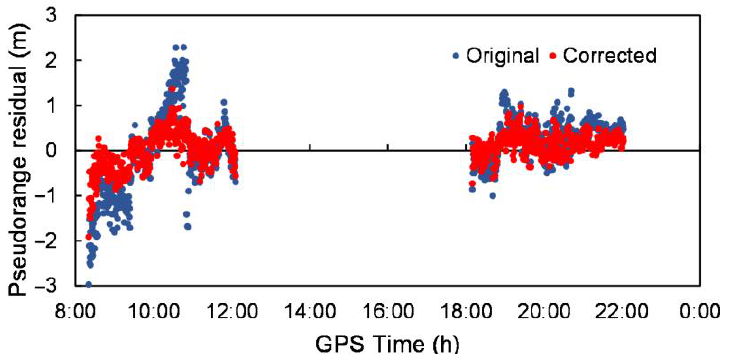
Figure 15. The pseudorange residuals of R21 on DOY 326, 2020, at BRUX station. The blue dots denote the original pseudorange residuals, and the red dots denote the corrected residuals using the multi-site model over 24